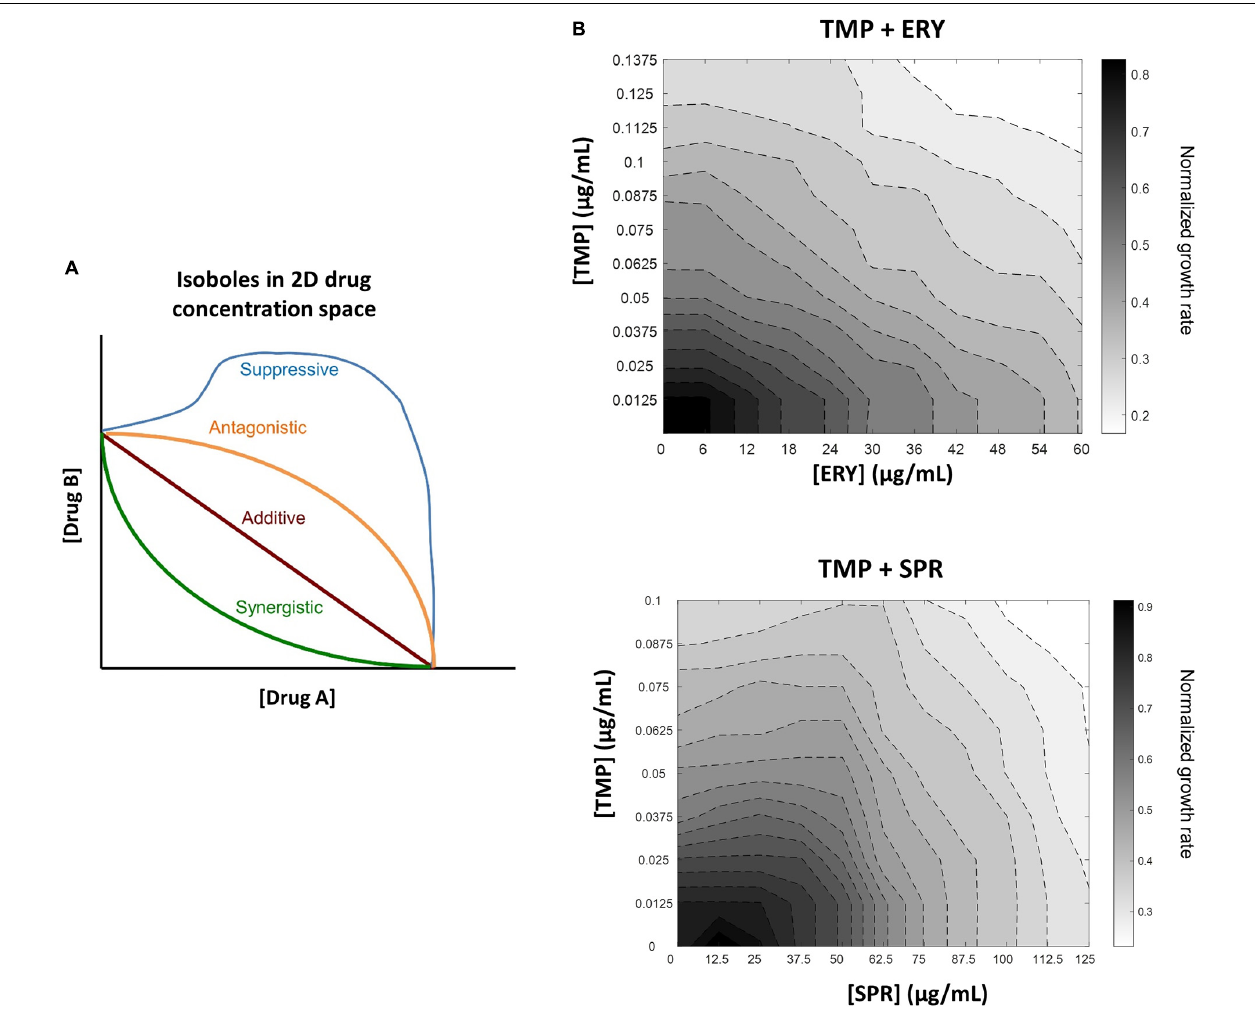
FIGURE 1 | In contrast to another ribosome-targeting antibiotic spiramycin (SPR), erythromycin (ERY) does not suppress trimethoprim (TMP) when tested against a crl- deficient MG1655 strain. (A) Schematic of different drug-drug interaction isoboles in a two-dimensional drug concentration space. Loewe additivity of drug-drug interactions is used for quantifying effects of drug combinations. Lines of constant inhibition (isoboles) in the 2D drug concentration space represent combinations of drugs A and B that result in same normalized growth rate. The four types of interactions shown are synergistic (green), additive (red), antagonistic (orange) and suppressive (blue). (B) TMP and ERY show almost additive interaction against crl- deficient E. coli MG1655. Isoboles in grayscale represent exponential growth rates normalized to that of the no-antibiotic treatment control in 2D concentration space. When tested against a crl- deficient E. coli MG1655 strain, ERY and TMP show an additive interaction. In contrast, SPR exerted a mildly suppressive effect on TMP under the same experimental